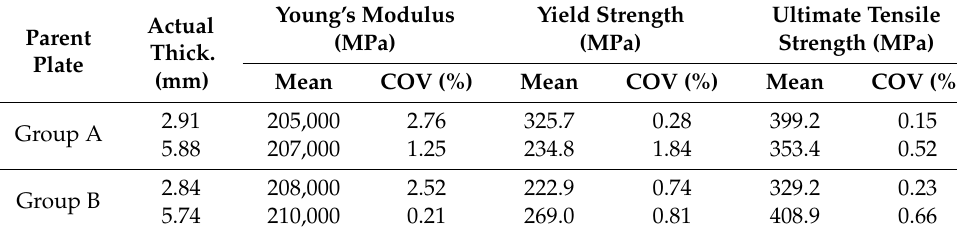
Table 1. Material properties of the test models.